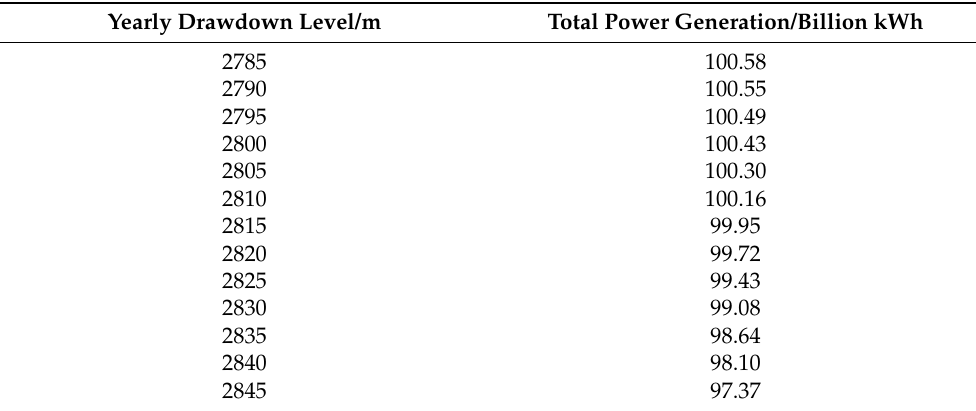
Table 2. Annual power generation of cascade system under different yearly drawdown levels of Lianghekou reservoir.